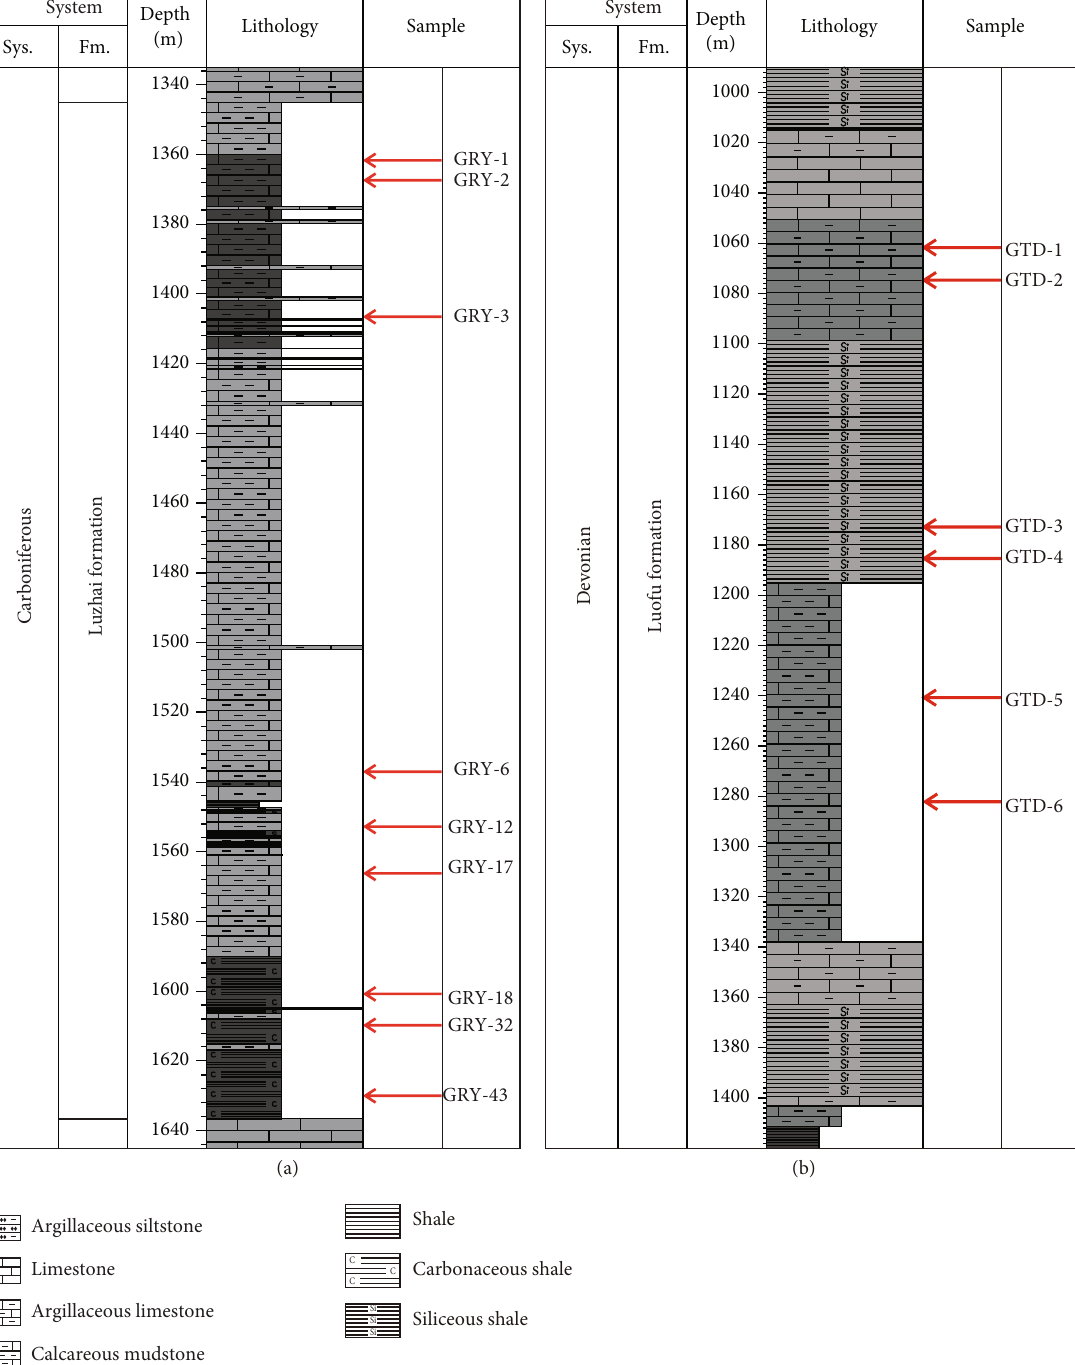
Figure 2: (a) Lithology and sampling location in well GRY1; (b) lithology and sampling location in well